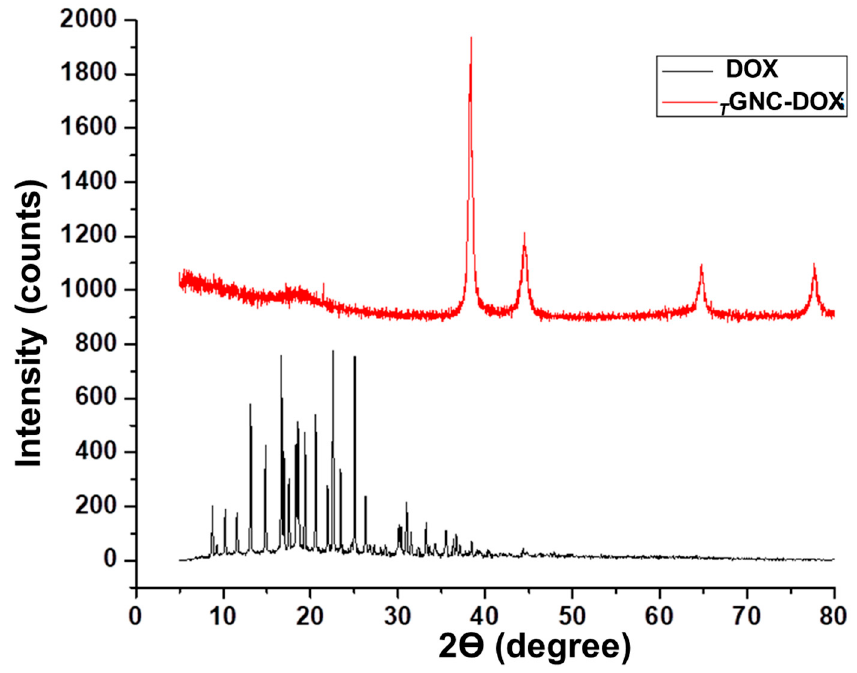
Figure 5. XRD pattern of DOX and T